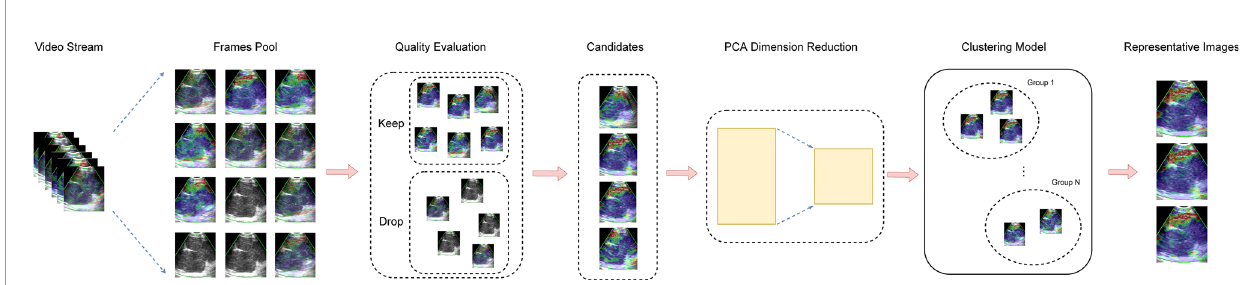
FIGURE 1 | The process of automatic selection of representative images. Frames were extracted from the video stream to construct a frame pool initially. Then, inferior frames are dropped during the quality evaluation procedure, and the eligible frames are kept as candidates for representative images. Next, the PCA was employed for dimension reduction. Ultimately, the clustering model select representative images from candidates. PCA, principal component